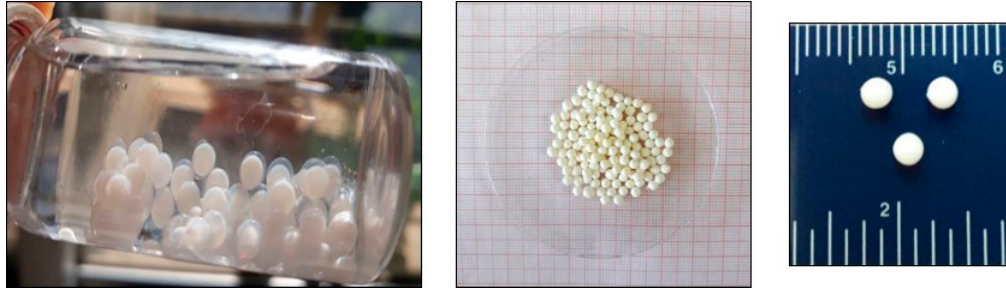
Figure 1. Spherical polyurea (PUA) aerogel beads during solvent exchange with acetone ( left ) and after dried with supercritical fluid (SCF) CO 2 ( middle and right ).